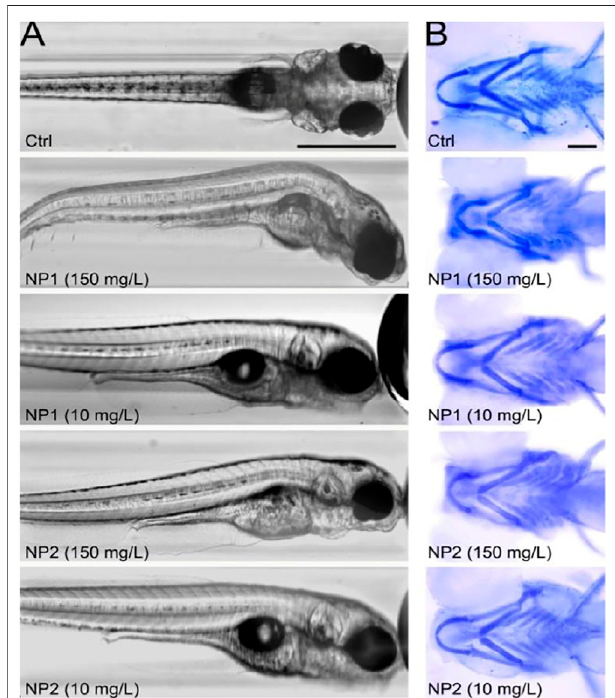
FIGURE 13 | Morphological and anatomical abnormalities induced by nanoparticles. Representative bright- fi eld images of different treatment groups showing (A) nearly complete larval body for morphological assessment; (B) craniofacial region for anatomical assessment. Scale